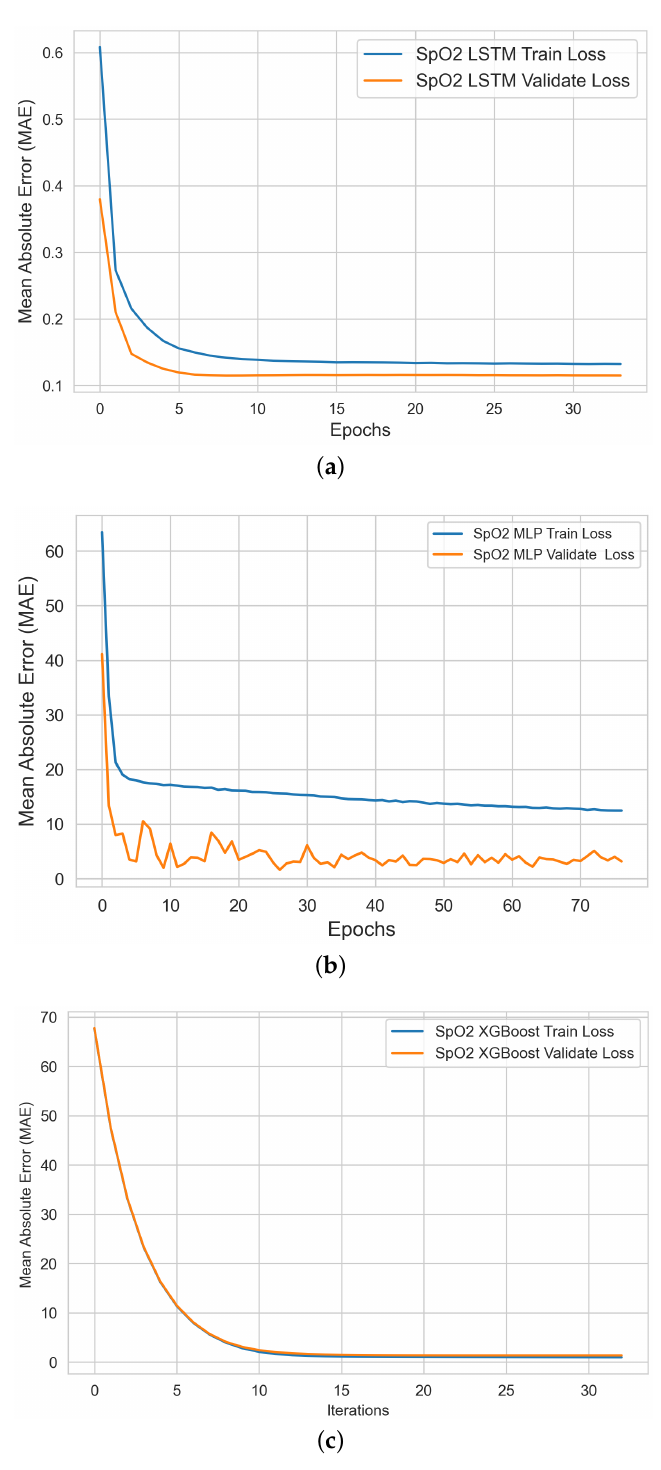
Figure 8. SpO2 level ML models’ performance curves during the learning and validation of